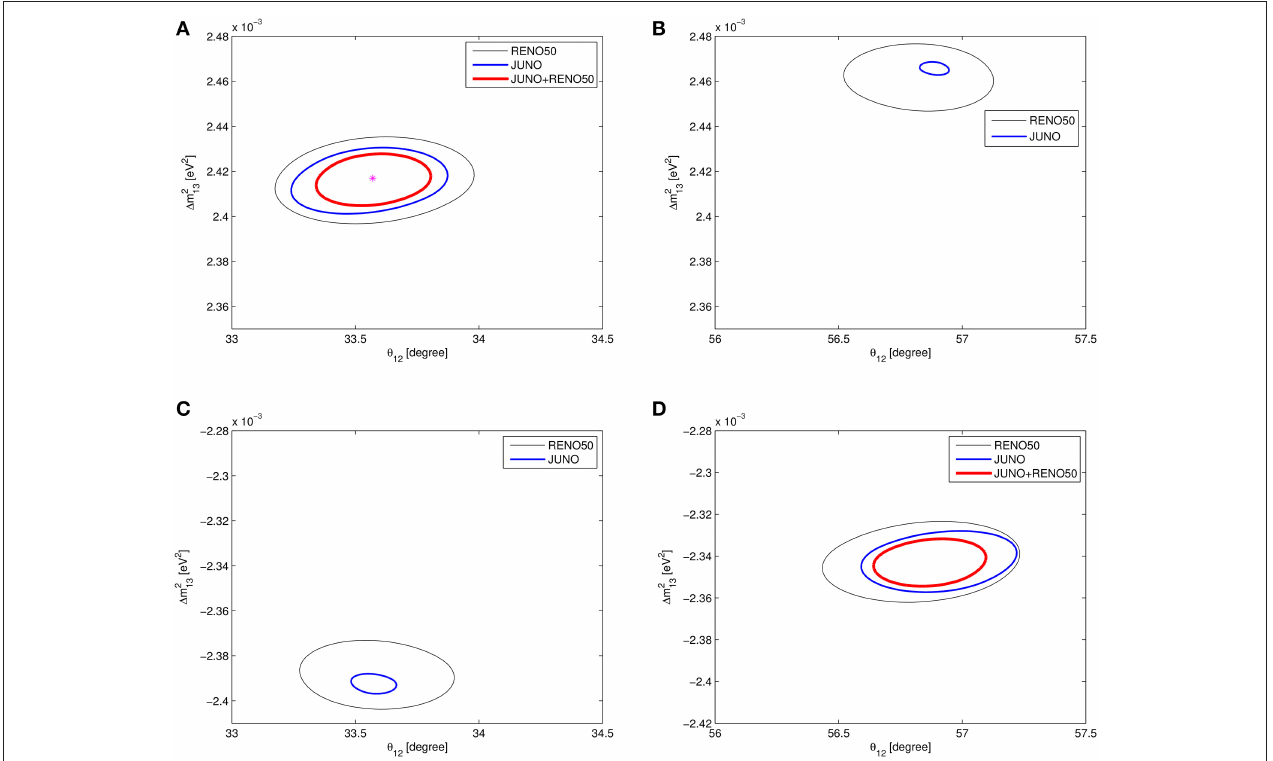
FIGURE 15 | The 3 σ C.L. contours for RENO-50 and JUNO after 5 years of data taking. The true values of the neutrino parameters, marked with a star in (A) , are taken to be 1 m 2 31 2.417 10 − 3 eV 2 , θ 12 33.57 ◦ , 1 m 2 21 (7.45 0.45) 10 − 5 eV 2 and θ 13 (8.75 0.5) ◦ . Panel (A) shows the true solution. Panels (B–D) = × = = ± × = ± show degenerate solutions respectively with opposite octant, with opposite mass ordering and with both opposite octant and mass ordering. Plots are taken